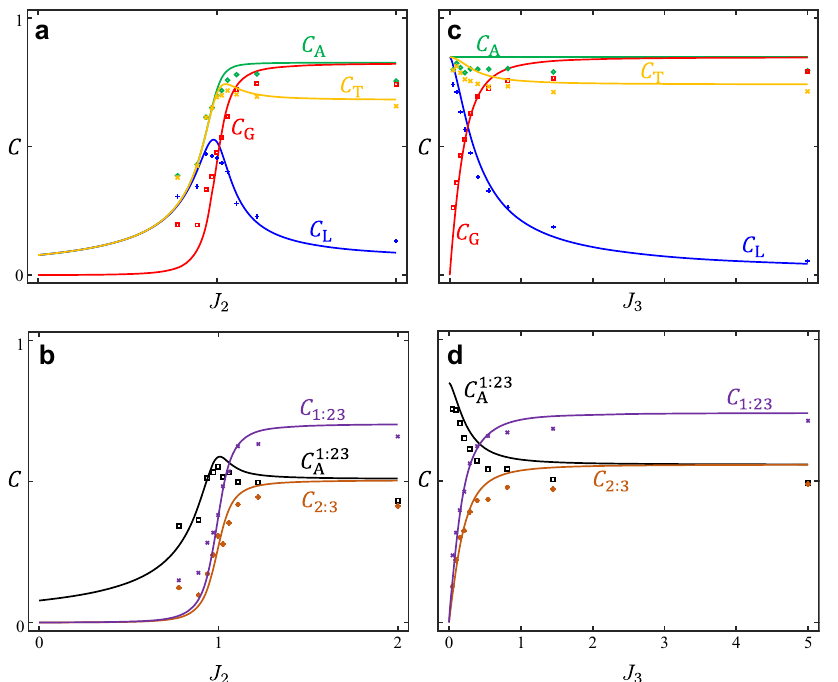
Fig. 2 The variation of different coherences as a function of the interaction parameters. Plot for the Hamiltonian H zz in ( a , b ) and H zzz in ( c , d ). The experimental data are shown by the points and the lines show the theoretically obtained